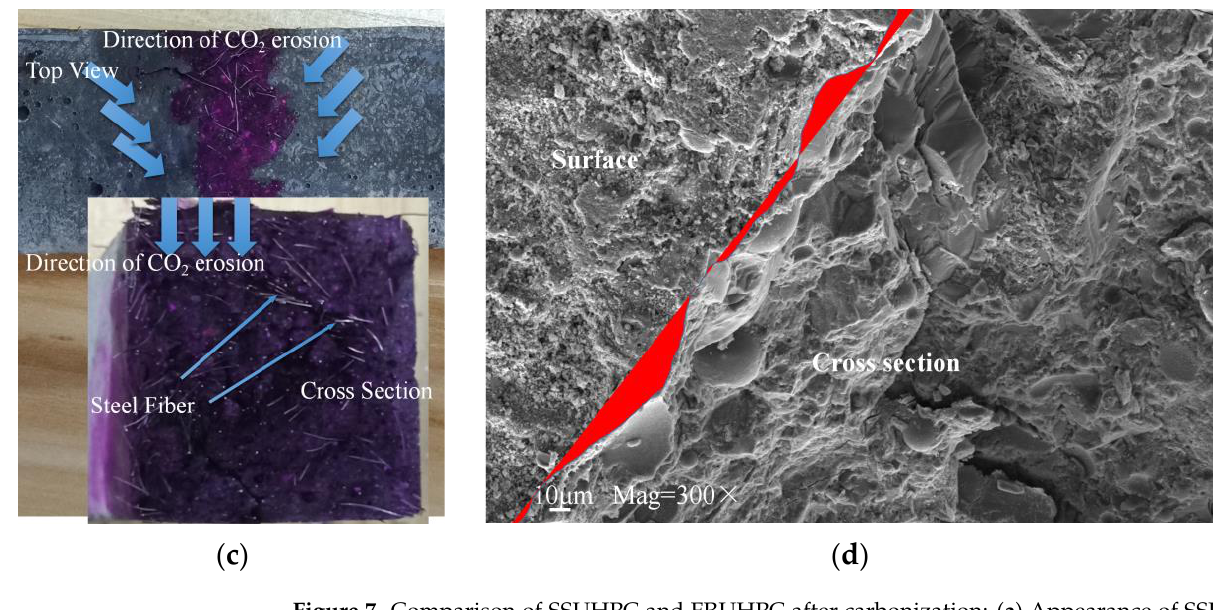
Figure 7. Comparison of SSUHPC and FRUHPC after carbonization: ( a ) Appearance of SSUHPC after carbonization; ( b ) Microstructure of SSUHPC after carbonization; ( c ) Appearance of FRUHPC after carbonization; ( d ) Microstructure of FRUHPC after carbonization.